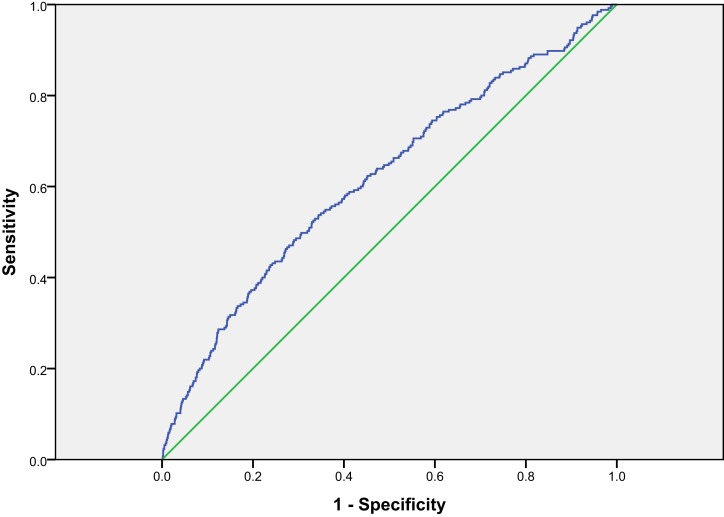
Receiver-operated characteristics curve for 25(OH)D for all-cause mortality.